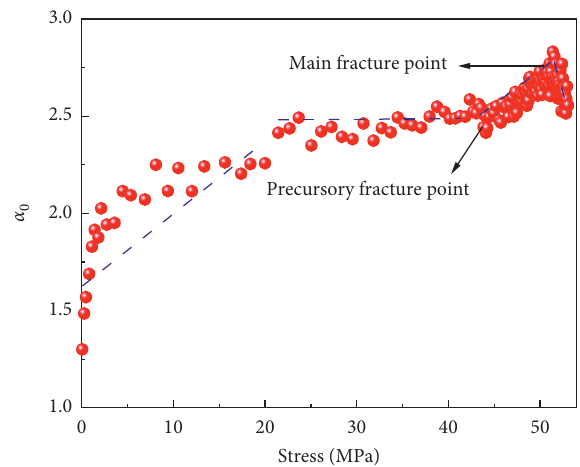
Figure 5: Multifractal parameter ( α